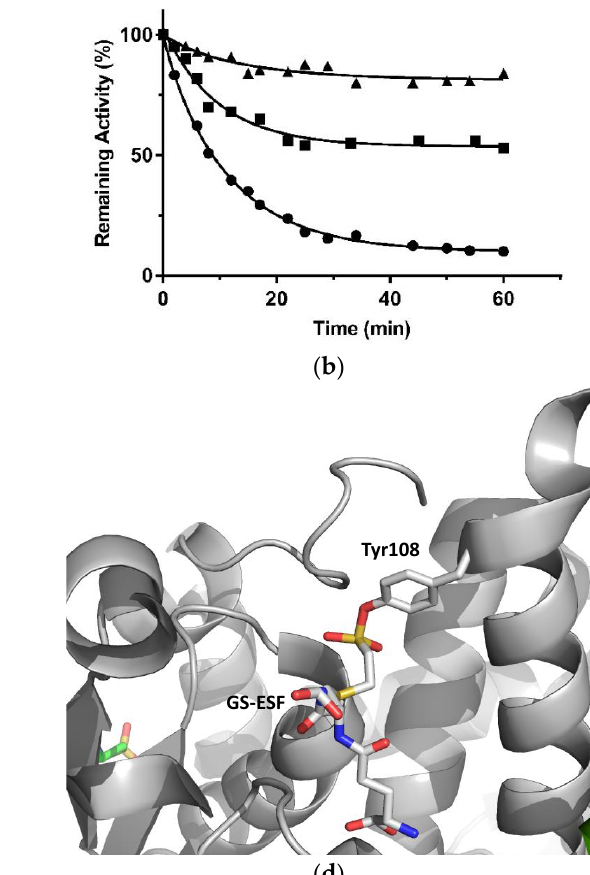
( d ): Crystal structure of GS-ESF bound to h GSTP1-1 (PDB ID code 5x79) [41]. The GSTP1-1 (gray)